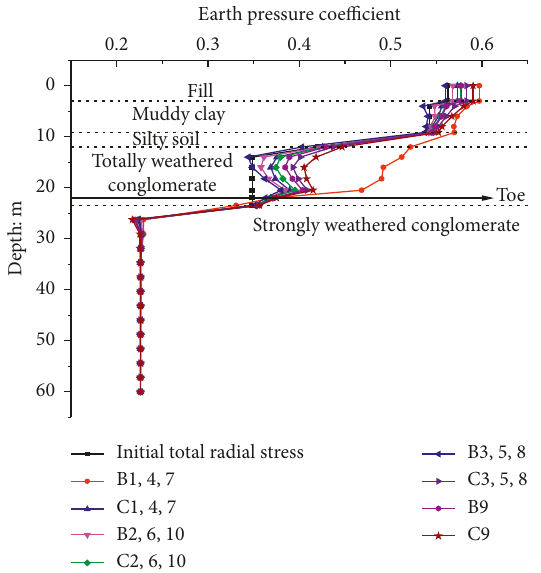
Figure 11: Effect of panel construction on lateral stress in terms of Earth pressure coefficient behind